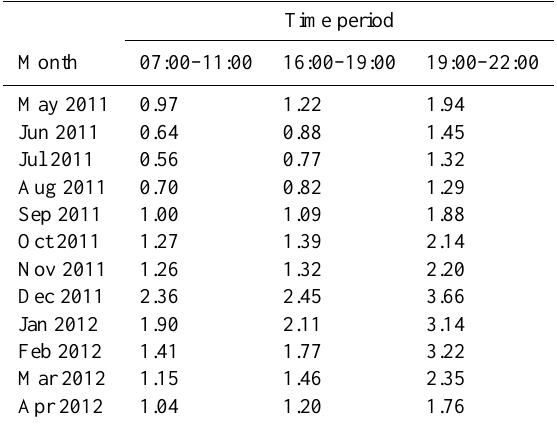
Table 3. The average OC-to-EC ratios, calculated as ratio of average Fig. S5 in the Supplement. Based on this Deming regression analysis for this “local emissions-influenced” period, a value of 0.5 was suggested to approximate (OC / EC) vehicle while 1.2 could serve as an upper limit of an (OC / EC) vehicle esti- mate at this roadside